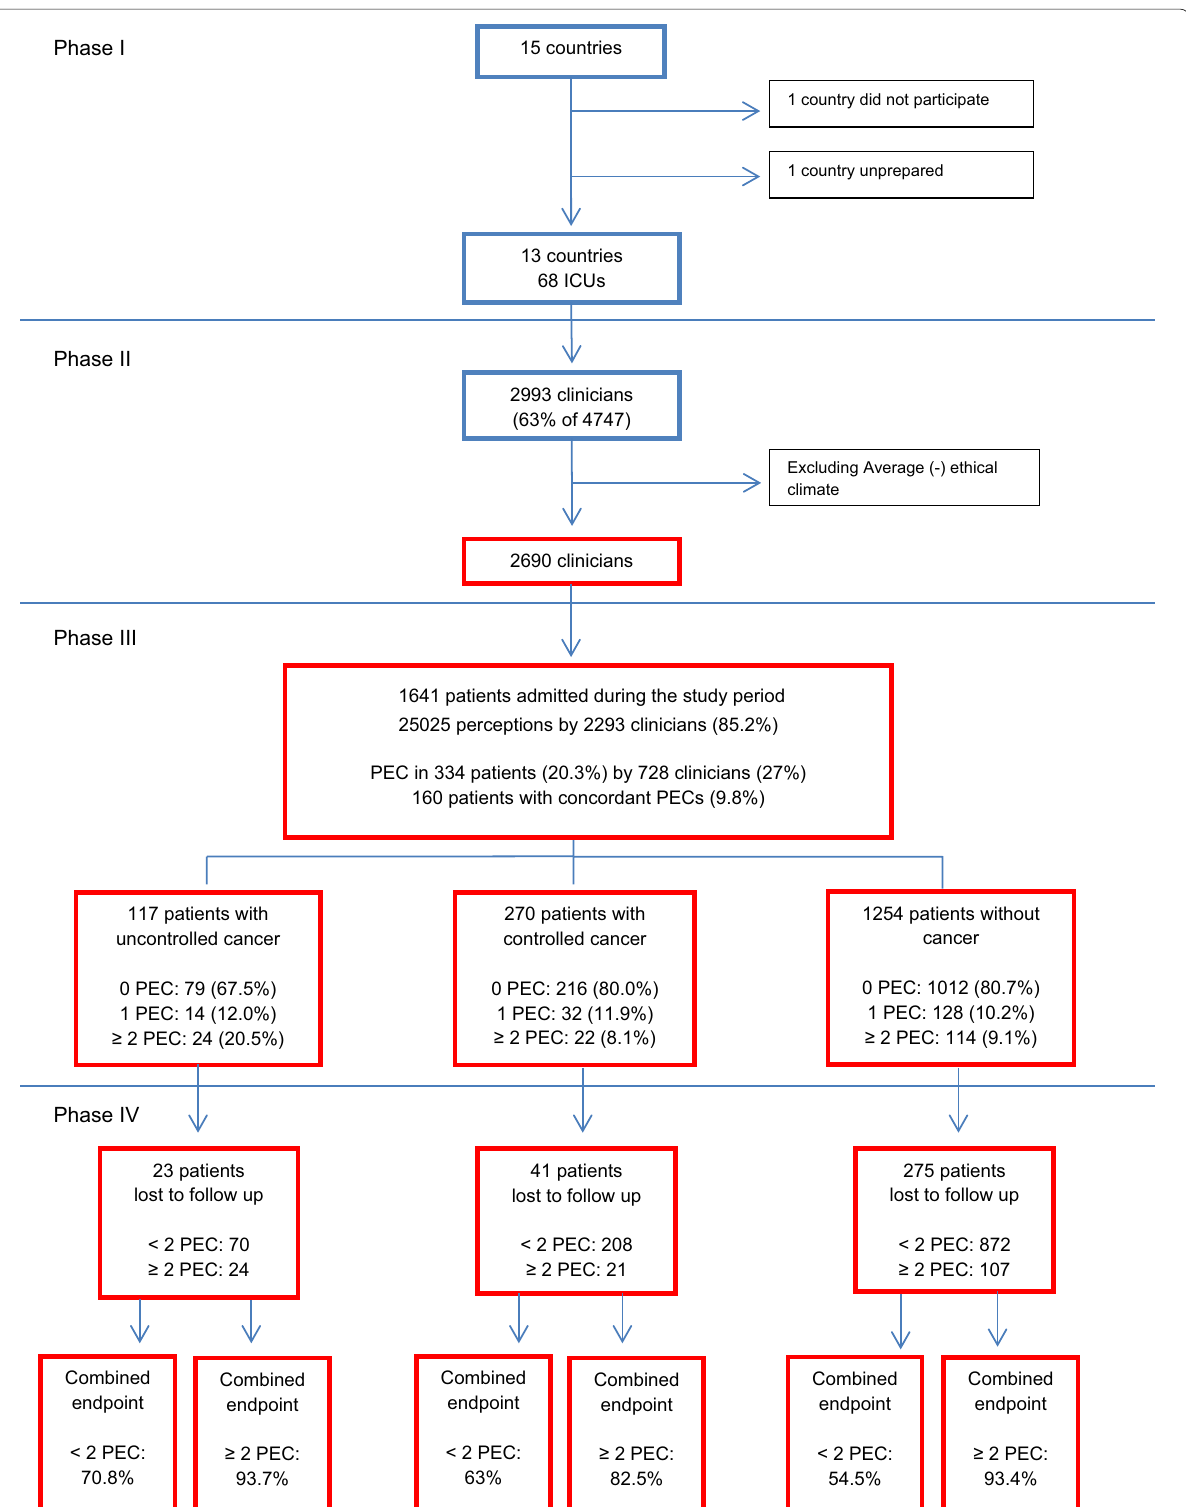
Fig. 1 Flowchart study: number of ICU’s, clinicians, perceptions and patients. PEC perceptions of excessive care. Combined endpoint: death, poor quality of life or not being at